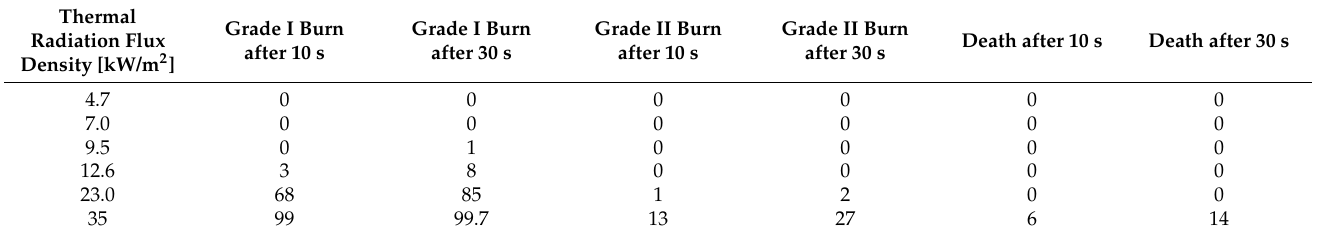
Table 3. Likelihood of occurrence of a specific type of injury suffered by persons due to exposure to thermal radiation for 5 s and 6 s caused by